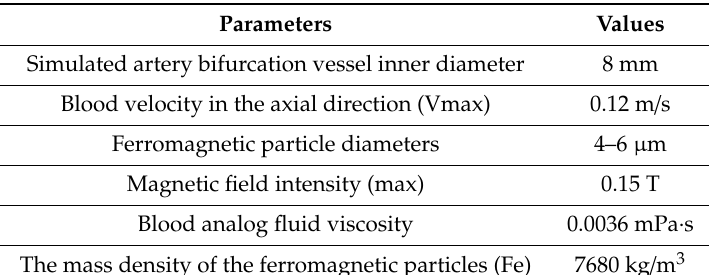
Table 1. Particle trajectory visualization